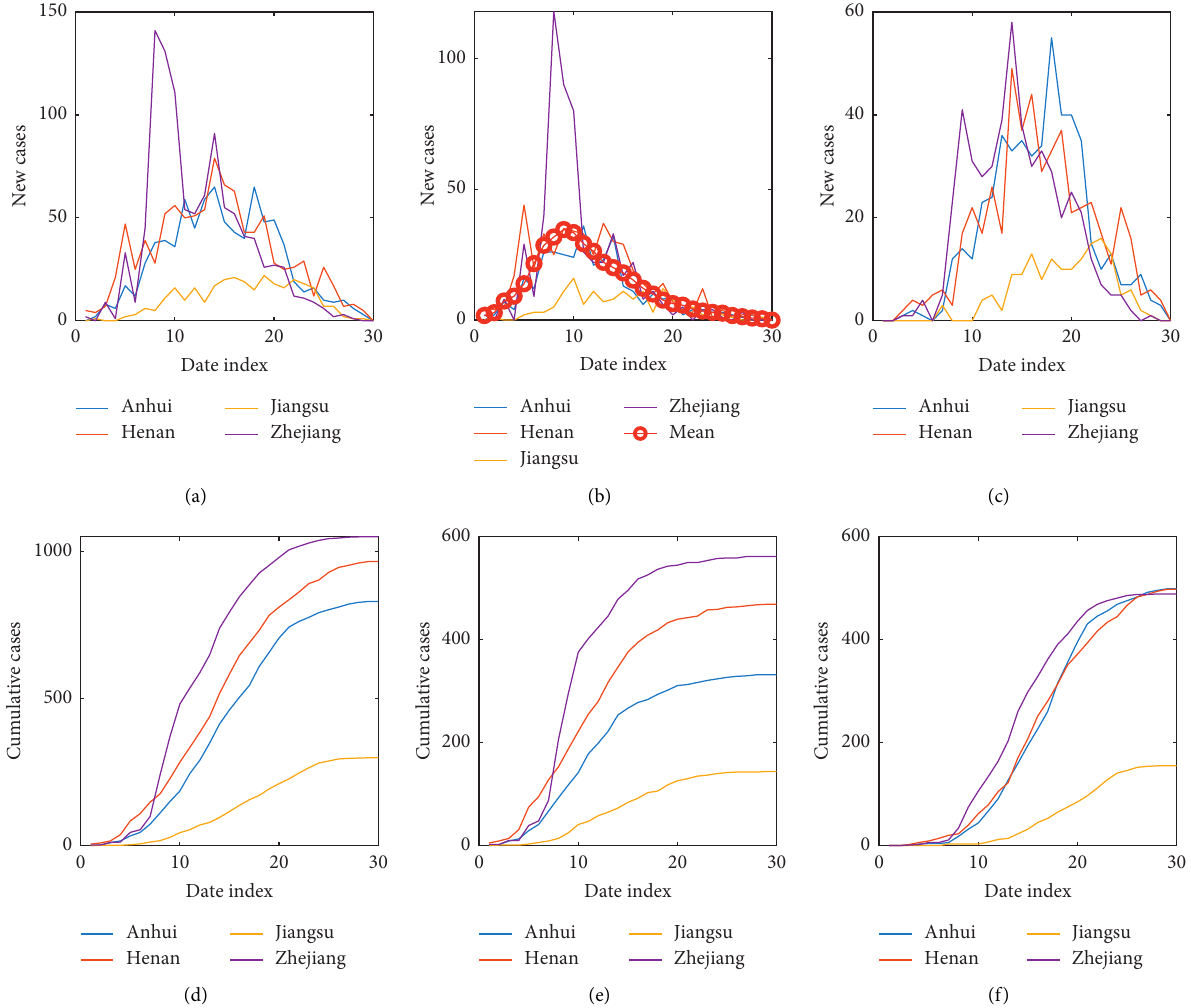
Figure 5: The time series for new cases and cumulative cases for different provinces. Legends for provinces are shown in subfigure (b). The total, immigrant, and local cases are considered, respectively. The rate r ( t ) of immigrant I ( t ) for simulations, which is the moving average of order 5 of the mean immigrant series of the four provinces, is as the red curve in (b). (a) Total. (b) Immigrant. (c) Local. (d) Total. (e) Immigrant. (f) Local.